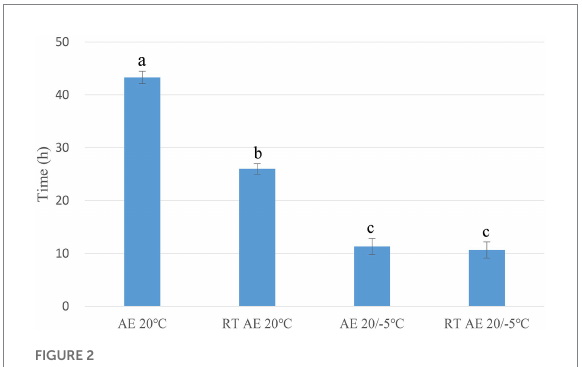
FIGURE 2 Aerobic stability of oat silages. a–c: means are significant different at 0.05 level. AE, aerobic exposure; and RT AE, room temperature aerobic